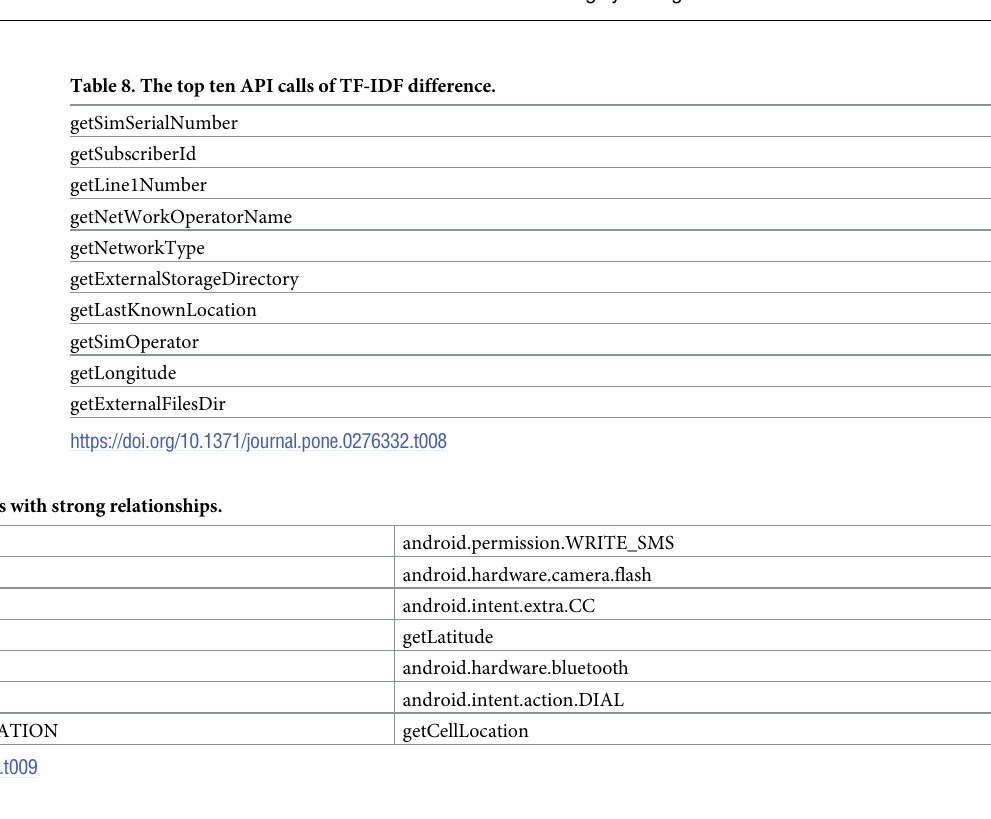
Table 10. The details of the features processed by CAPCC.